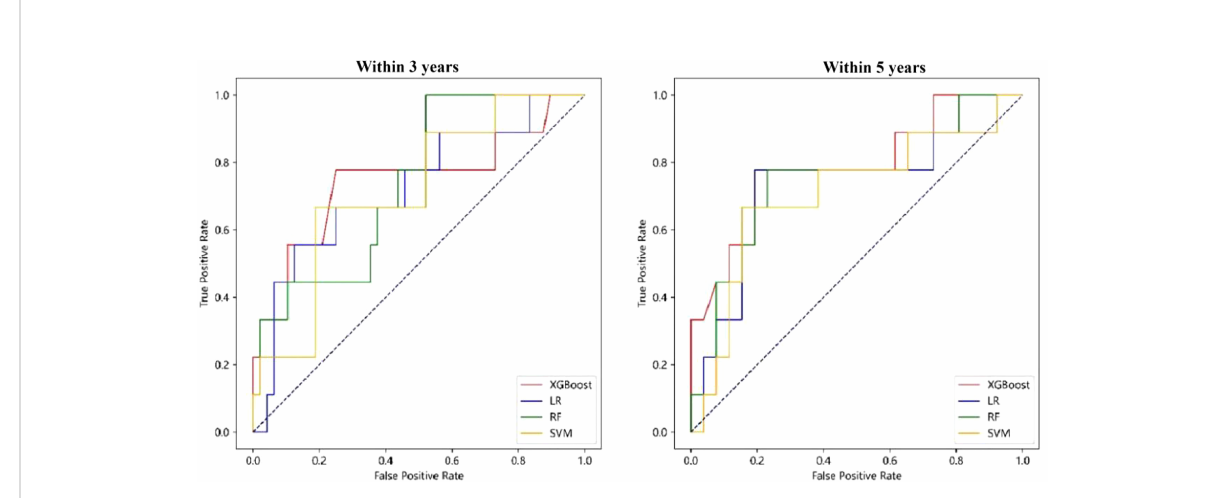
FIGURE 4 ROC curve of “ TCM syndrome prognostic model ”